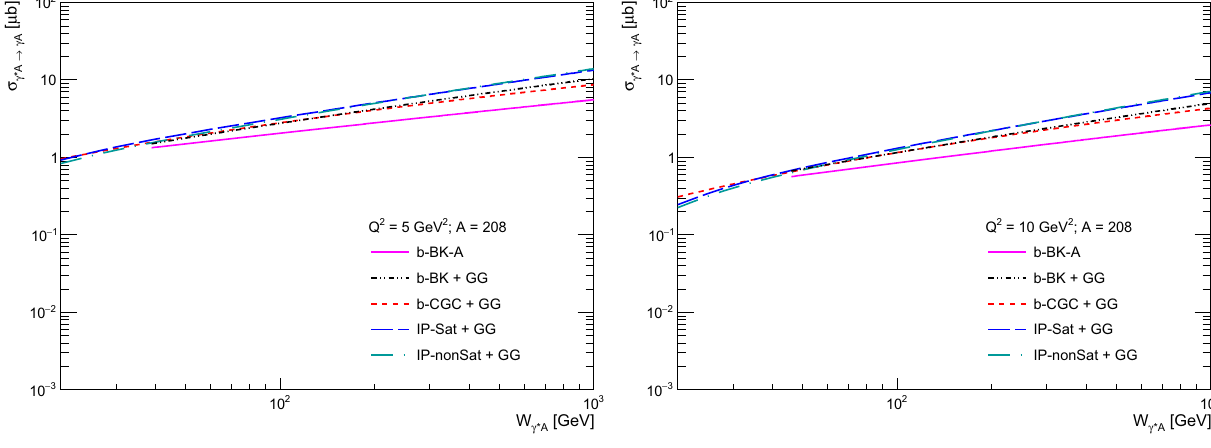
Fig. 6 Predictions for the energy dependence of the nuclear DVCS cross section considering distinct models for the dipole-nucleus scattering amplitude, A = Pb , and different values of the photon